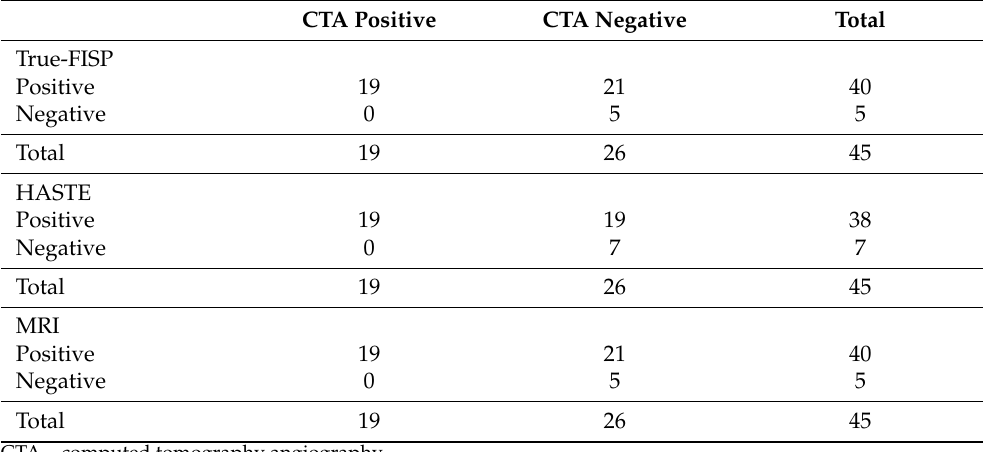
Table 3. Contingency tables of true-FISP, HASTE, and MRI (true-FISP and HASTE combined) assessments for endoleaks compared to CTA.